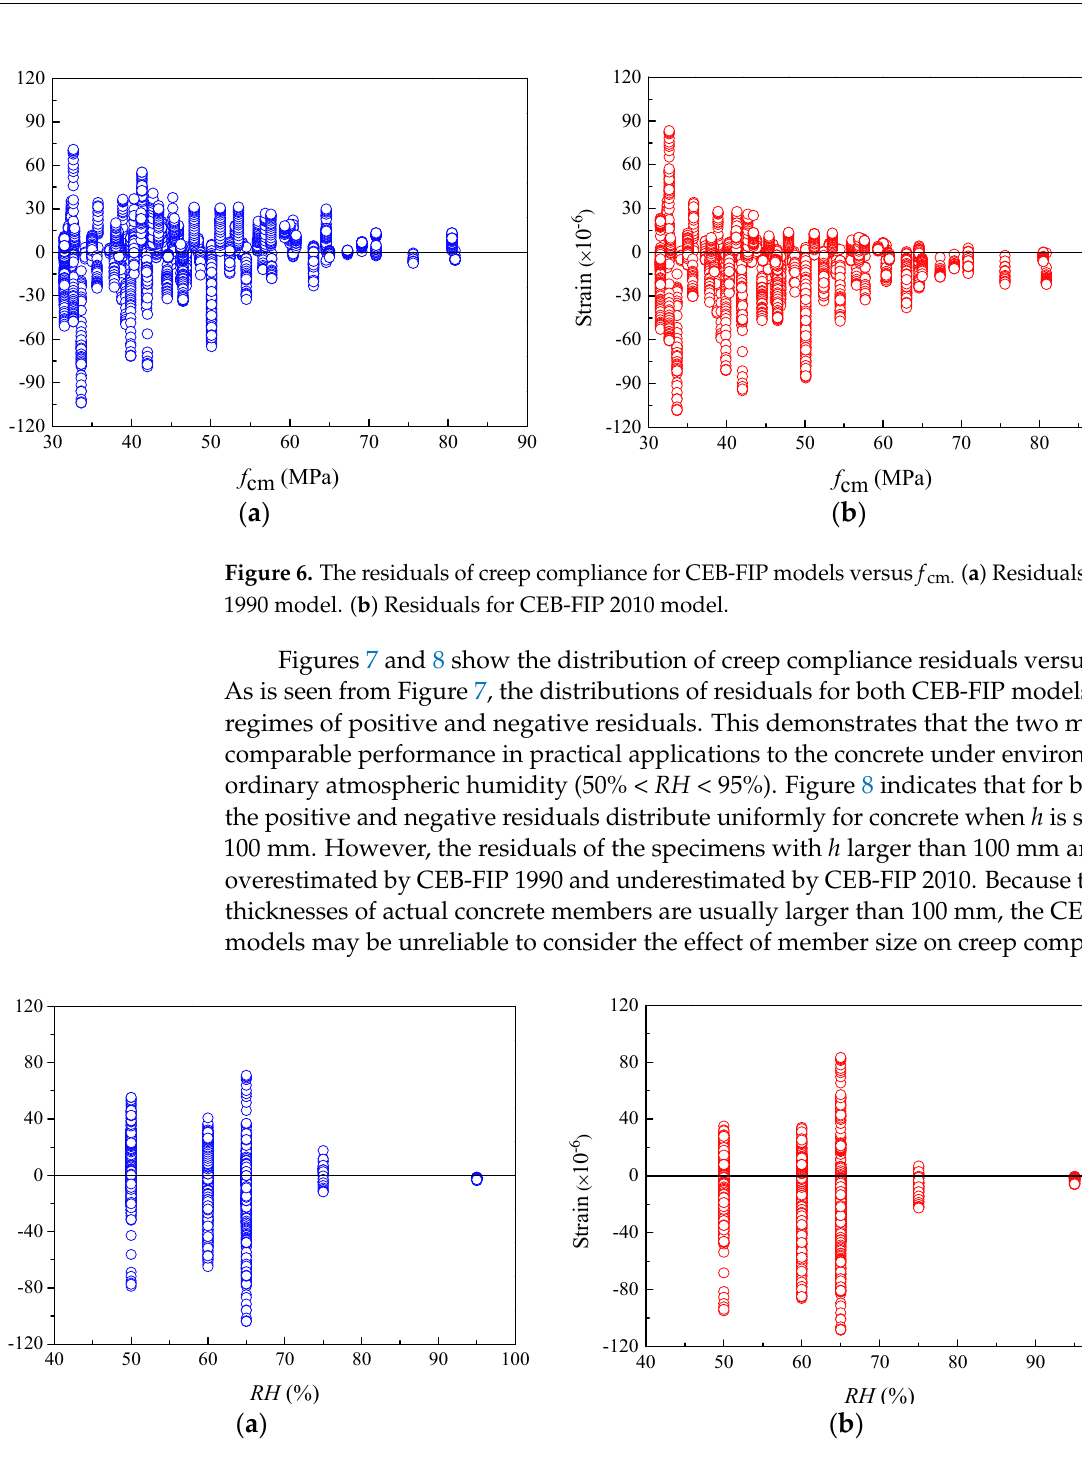
Figure 7. The residuals of creep compliance for CEB-FIP models versus RH. ( a ) Residuals for CEB-FIP 1990 model. ( b ) Residuals for CEB-FIP 2010 model.